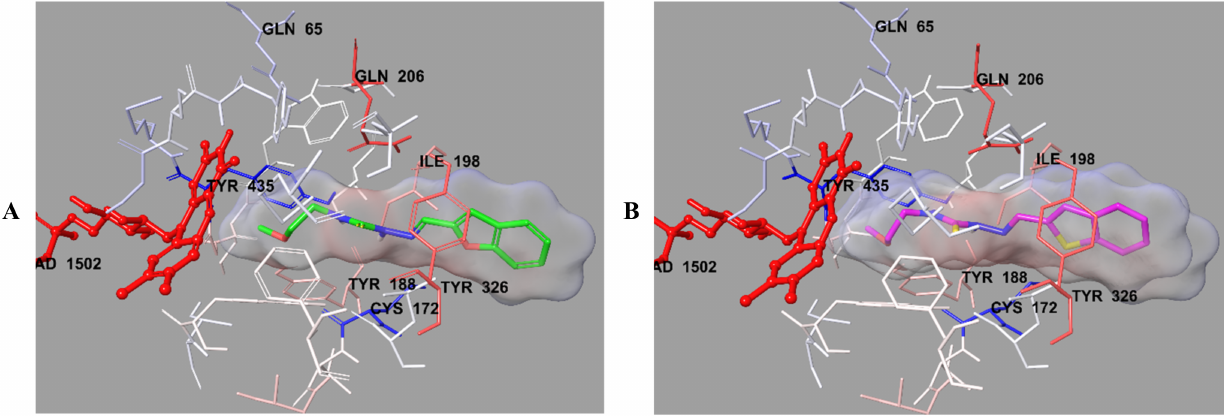
Figure 9. The electrostatic interactions of compounds 2b ( A ) and 2h ( B ) with active region of h MAO-B. The residues are colored (blue, red, and pink) according to the distance from ligand by Per-Residue Interaction